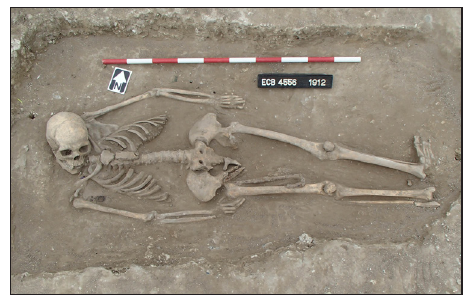
Figure 7: Anglo-Saxon graves from Soham, Cambridgeshire (Photo Kieron Heard).